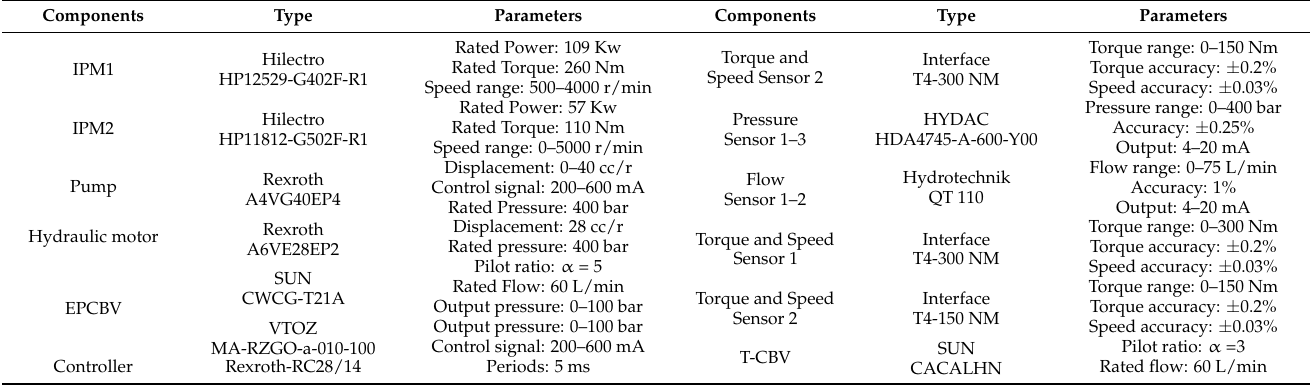
Figure 7. ( a ) Schematic of the test bench for EPCBV system, ( b ) photograph of the test bench 1—IPM1; Table 1. Parameters of main components in PCMH system for EPCBV and